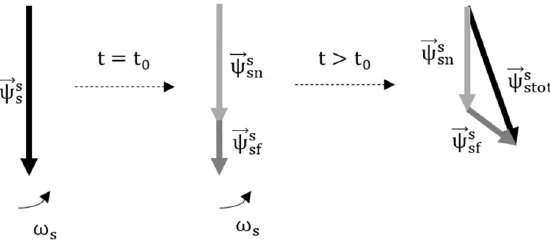
Fig. 4 Evolution of stator flux during a dip